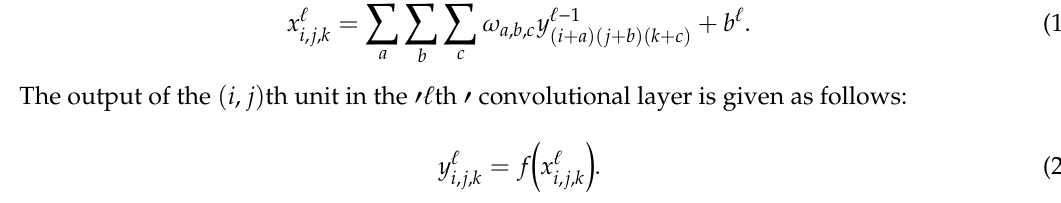
Figure 3. Typical architecture of 3D CNN.